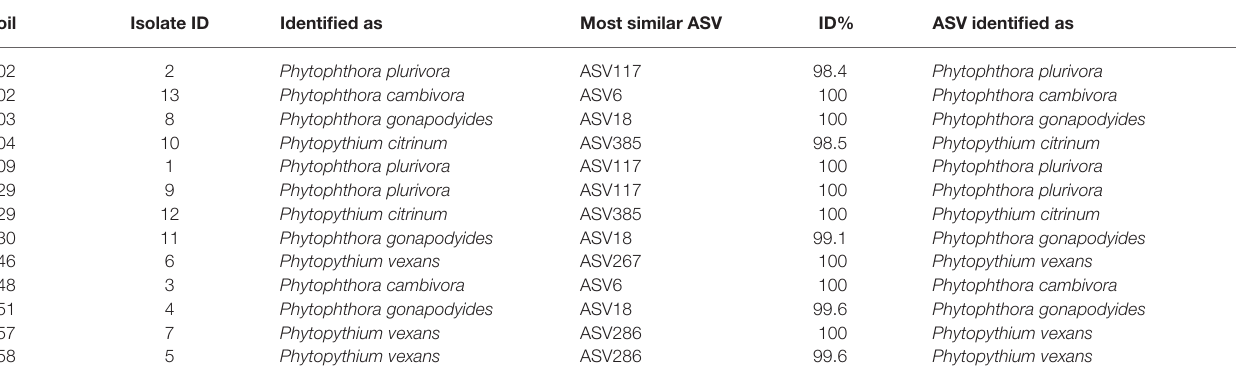
TABLE 2 | Thirteen isolates obtained from rhizospheric soil samples after enrichment, their species identities and corresponding ASVs recovered in metabarcoding. Soil Isolate ID Identified as Most similar ASV